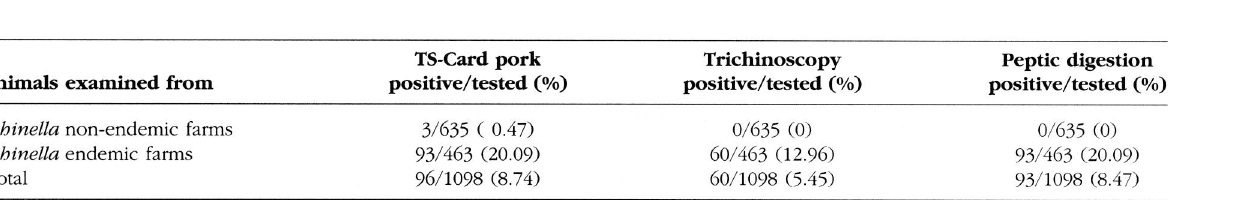
and the OIE Manual of Standards for Diagnostic Tests and Vaccines (2000). The 28 fields of one compres- sorium were examined for each sample.